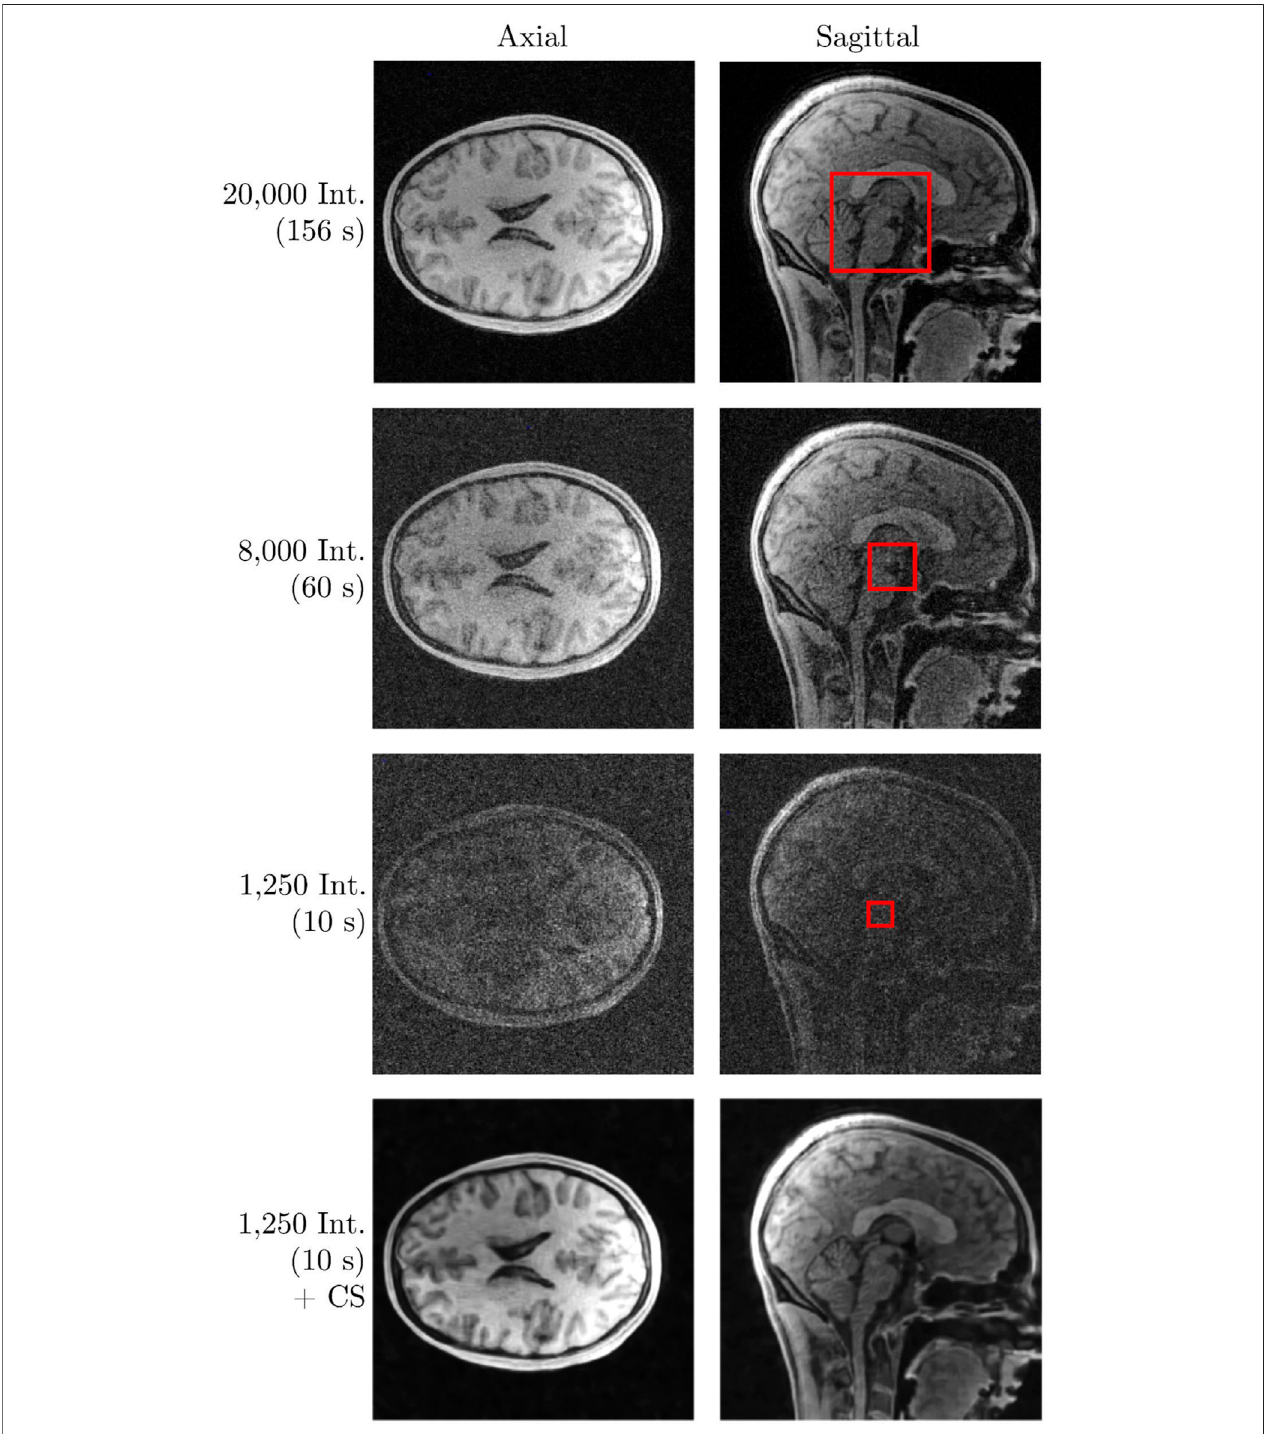
FIGURE4| Simulated PSF S sinthe xy -planewith z =0ofthepresented3D ζ -basedSpiraltrajectory. ThePSF S in (A) corresponds to3.29-fold undersampling,the PSF S in (B) to 6.43-fold undersampling, (C , D) to 9.33-fold and 12.98-fold undersampling respectively. Logarithmic plot of the centre region of all four sampling point spread functions shown in (E) and the same for the entire cross section in (F) .